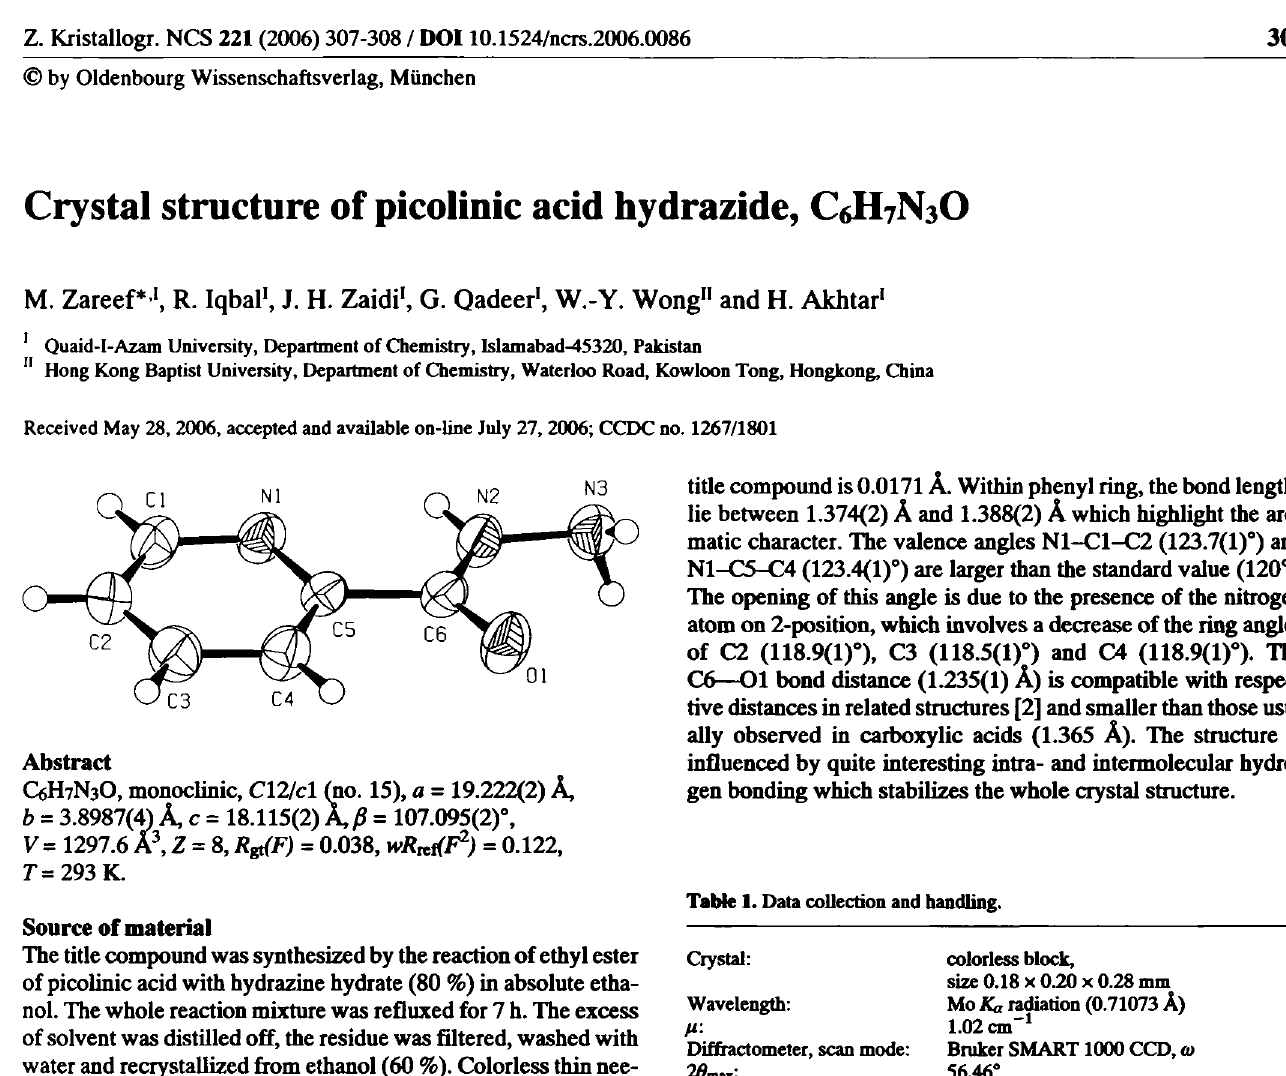
Table 2. Atomic coordinates and displacement parameters (in A 2 ).